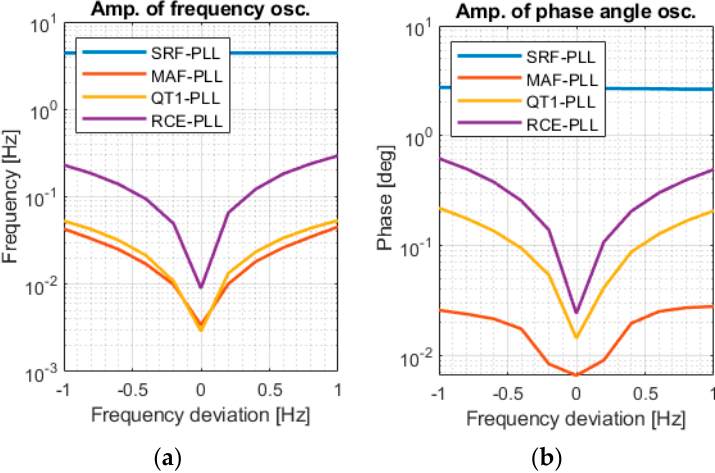
Figure 15. Effect of fundamental frequency deviation on the amplitude of undamped oscillations during voltage sag. ( a ) Frequency; ( b ) phase angle.